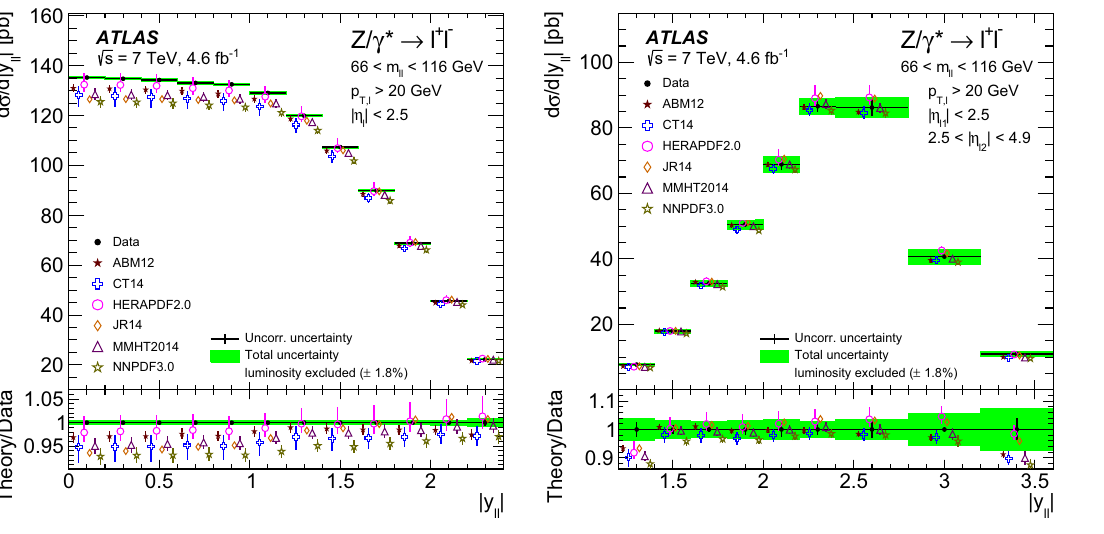
compared to the data ( full points ). The ratio of theoretical predictions to the data is also shown. The predictions are displaced within each bin for better visibility. The theory uncertainty corresponds to the quadratic sum of the PDF uncertainty and the statistical uncertainty of the